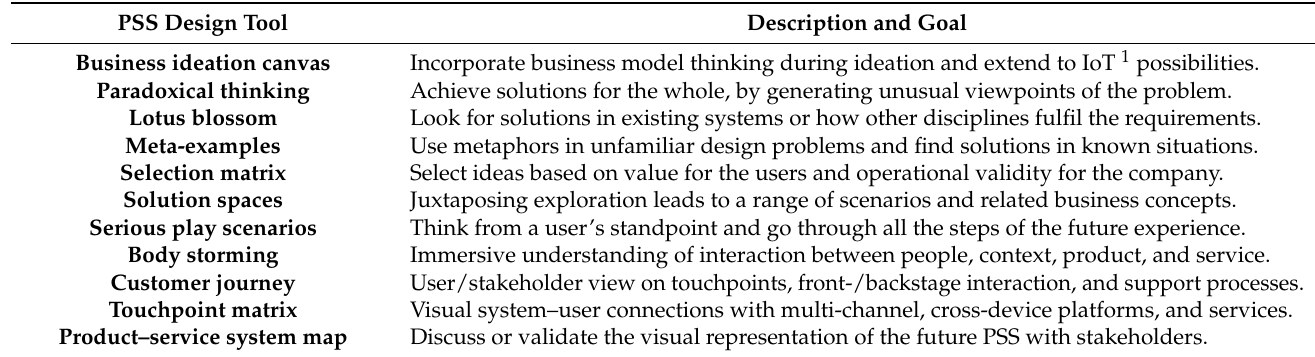
Table 5. PSS design tools and descriptions during the explore